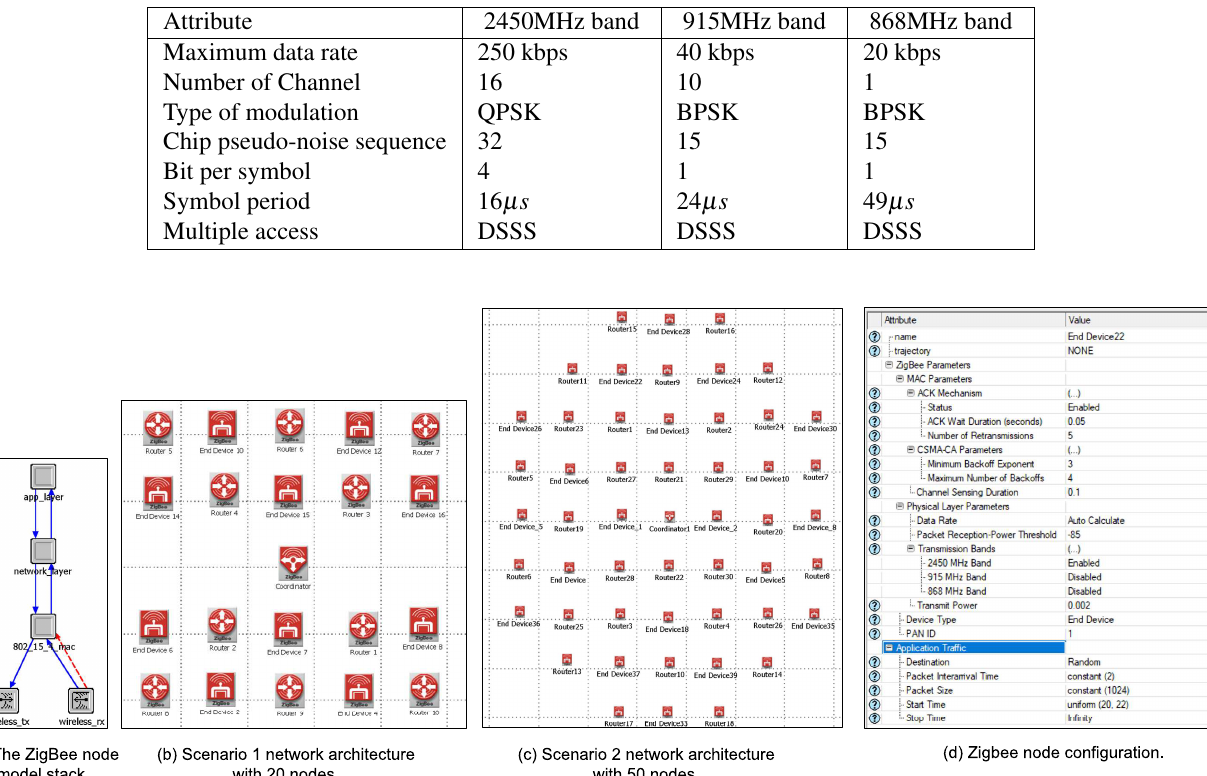
Figure 2. Network simulation and Zigbee node